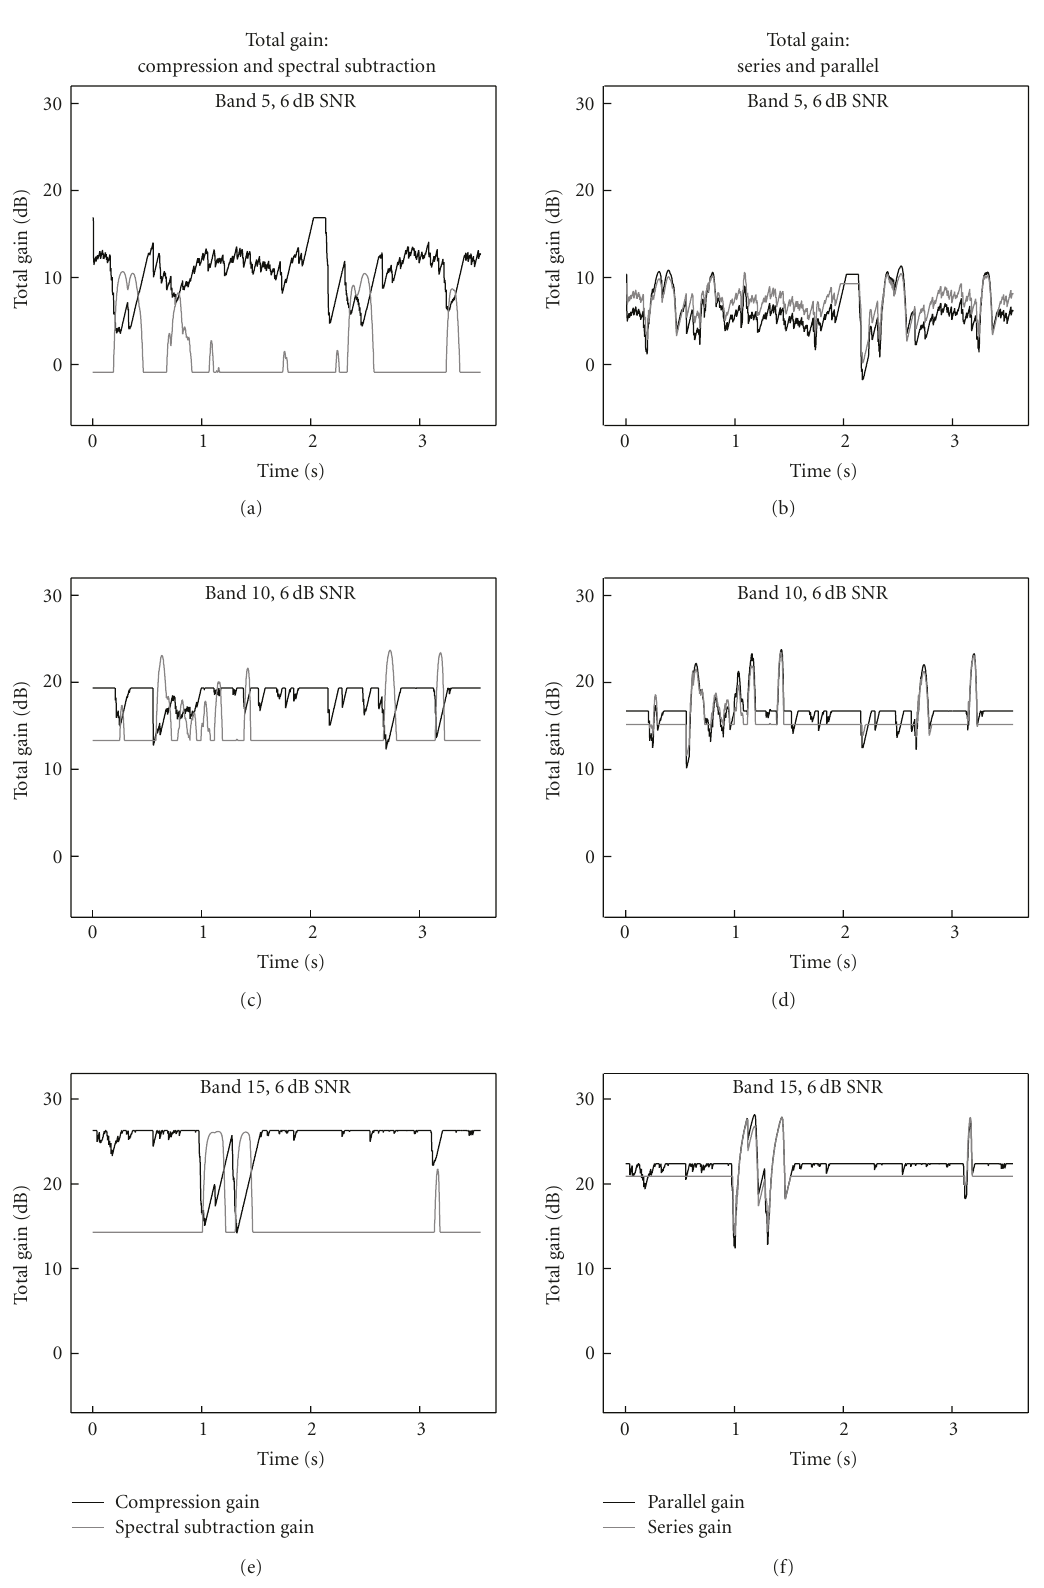
Figure 5: Gain versus time plots depicting the total gain modifications at 6dB SNR for bands 5 (cf = 583 Hz), 10 (cf = 1625 Hz), and 15 (cf = 4541 Hz) for the average HI listener. The gain modifications include the gain prescribed from the signal processing algorithm(s), the long-term spectrum equalization, and NAL-R. Compression (black) and spectral subtraction (gray) are shown in the left panels. Parallel processing (black) and series processing (gray) are shown in the right